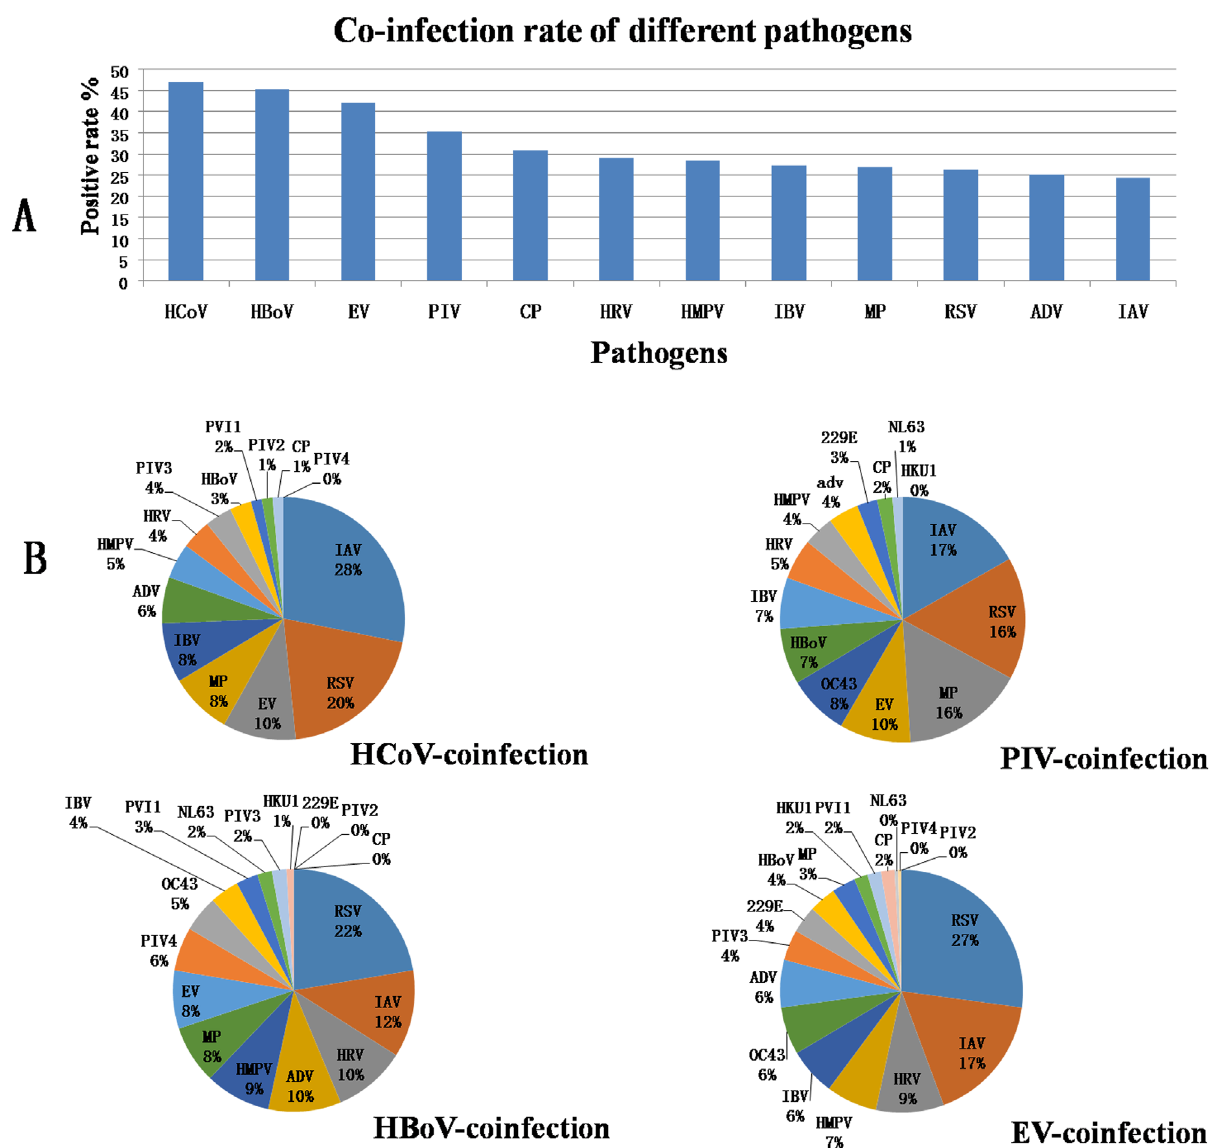
Fig 5. The distribution of co-infections over five years. A, CIRs for different pathogens; B, the 4 highest pathogen CIRs and their constituent